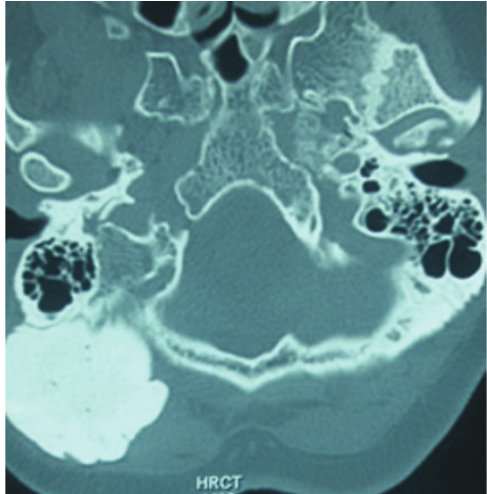
Figure 2: CT bone window showing the large lesion in the right suboccipital and adjacent mastoid region.